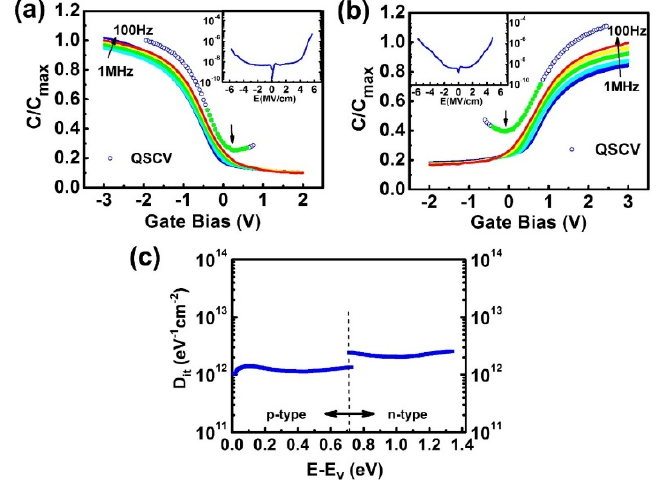
Figure 5. CV s of ALD ‐ Al 2 O 3 /ALD ‐ Y 2 O 3 (2.3 nm)/GaAs(001) ‐ 4 × 6 MOSCAPs for p ‐ type GaAs ( a ) and for n ‐ type GaAs ( b ) with insets showing their respective JE curves; and ( c ) showing D it distribution within GaAs band gap.